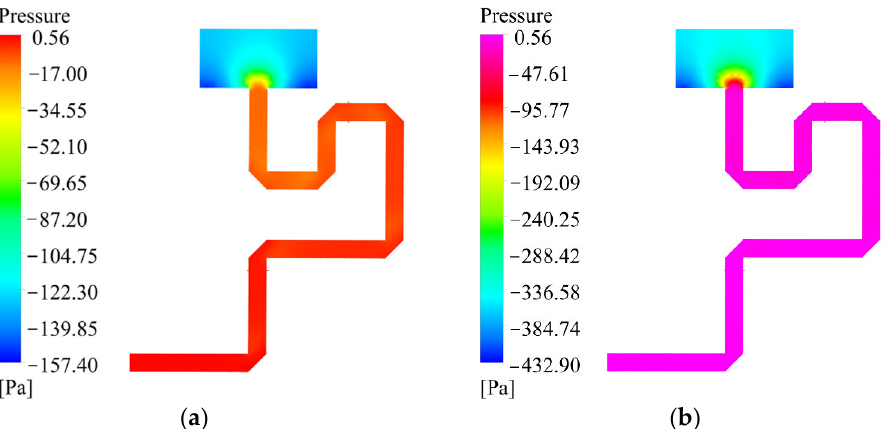
v with L for different v . z out